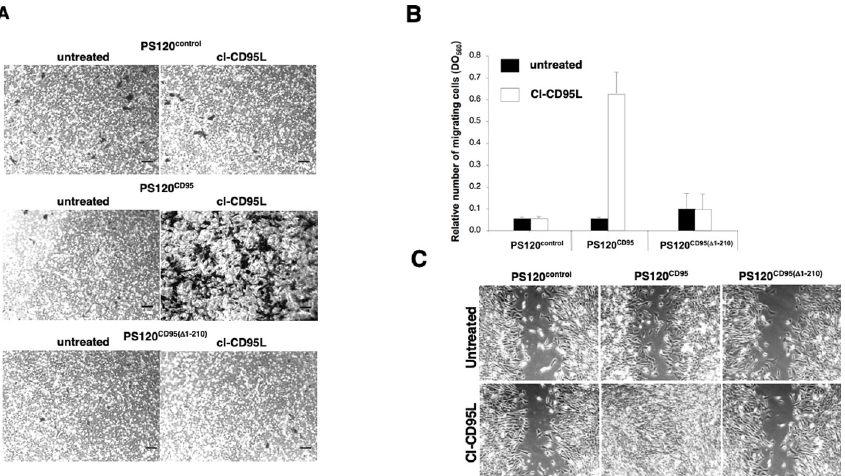
Fig 3. Cleaved CD95L promotes cell migration through a DD-dependent signal. (A) The CD95-deficient PS120 (wild type NHE1-reconstituted PS120 control ) and its counterparts expressing human wild type CD95 or DD-truncated CD95 were seeded in a Boyden chamber in the presence of cl-CD95L (100 ng/ml) or with control medium (supernatant from pcDNA3.1(+)-transfected HEK cells—Untreated) and incubated for 24 h. The filter was removed, the upper side containing the non-migrating cells was wiped out with cotton-tipped swabs and migrating cells in the opposite side of the filter were fixed with methanol and stained (Giemsa). For each experiment, five pictures of random fields were taken, and a representative picture was depicted (Bars = 70 μ m). (B) Cells were treated as described in (A). To quantify cell motility, Giemsa-stained migrating cells from the lower side of the membrane were lyzed and absorbance was measured at 560 nm. (C) Wound healing assay, a confluent monolayer of the indicated cells was “wounded” with a tip and then cells were incubated for 24 h in the presence of 100 ng/ml of cl-CD95L or a control medium (supernatant of pcDNA3.1(+)-transfected HEK cell) (untreated) and pictures were acquired (Bars = 50 μ m). Pictures are representative of 5 independently performed experiments.